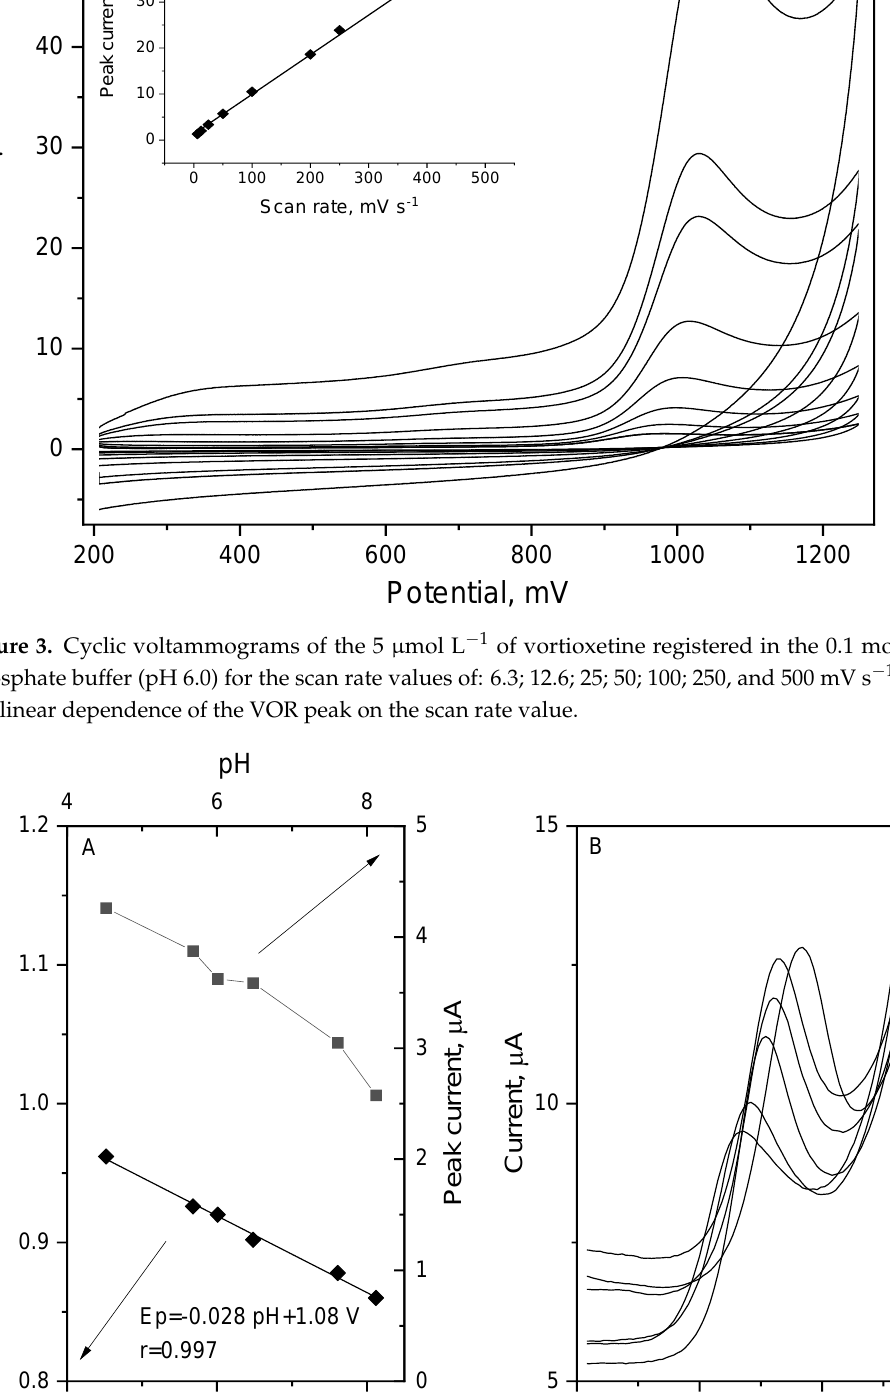
Scheme 1. Proposed mechanism of vortioxetine electrochemical oxidation.